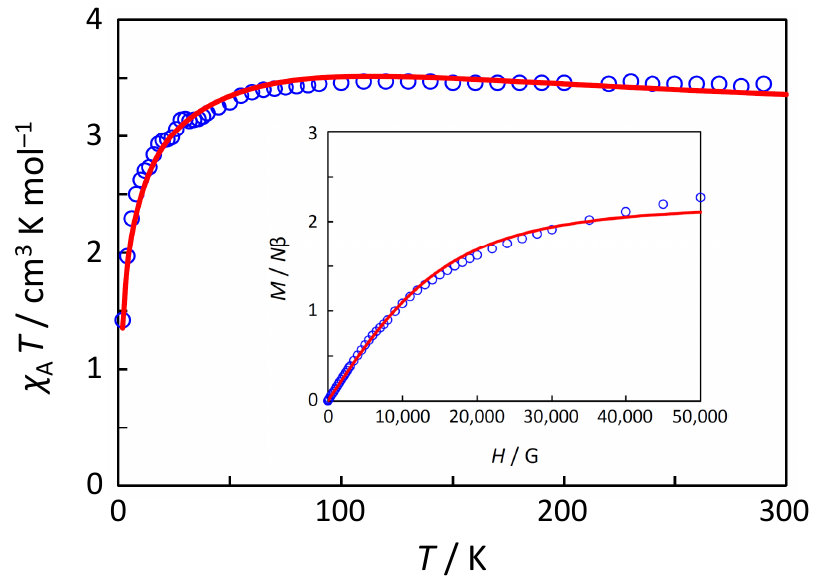
Figure 2. The χ T versus T plot and the M versus H plot (insertion). The observed data ( ◦ ) and the theoretical curves ( - ) with the best-fitting parameter set ( λ , κ , v , θ ) = ( − 100 cm − 1 , 0.66, 5.5, − 1.5